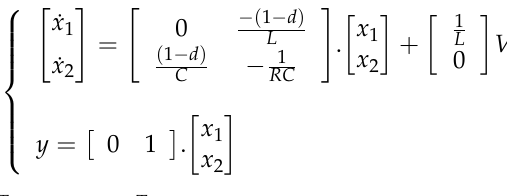
Figure 6. Step-up DC/DC converter diagram.